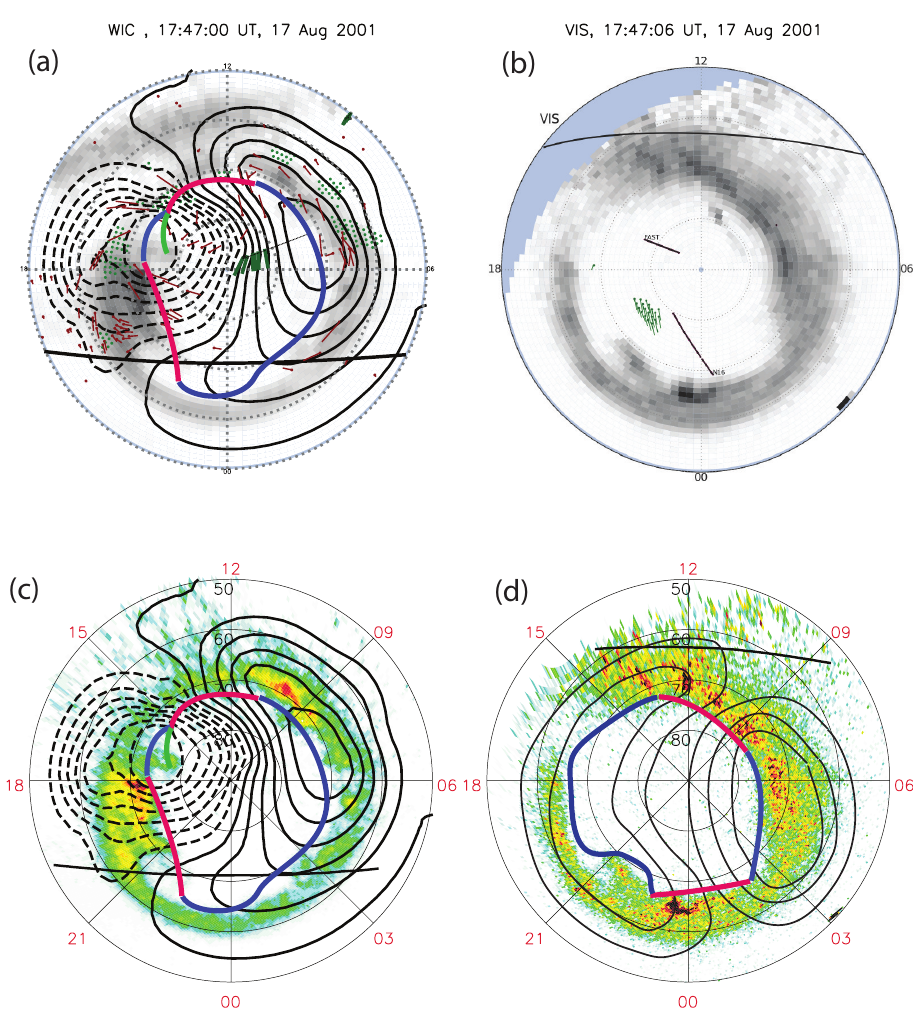
Figure 11. Convection patterns in the two hemispheres at 17:47UT, 17 August 2001. (a) SuperDARN line of sight (green dots), SuperMAG (brown arrows) and DMSP SSIES (green arrows) are used to estimate the global convection pattern in the Northern Hemisphere. Blue and red lines indicate the open–closed boundary, where the red lines are dayside and nightside reconnection regions. The green line indicates lobe reconnection. (b) Southern Hemisphere where a few vectors from SuperDARN are available (green arrows). (c) Similar convection pattern to that from panel (a) overlaid on the auroral intensities. (d) Convection pattern and open–closed boundary in the southern pattern drawn by hand, guided by the few available SuperDARN vectors (b) and auroral features of dayside and nightside